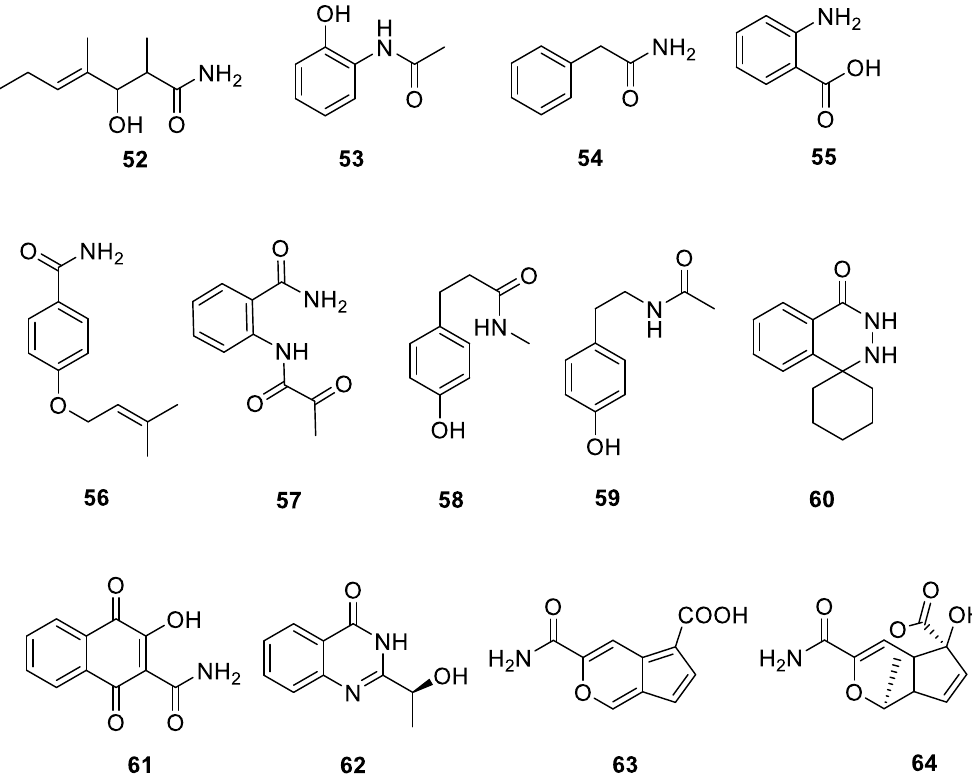
Figure 8. Chemical structures of compounds 52 − 64 from lichen-associated actinomycetota.